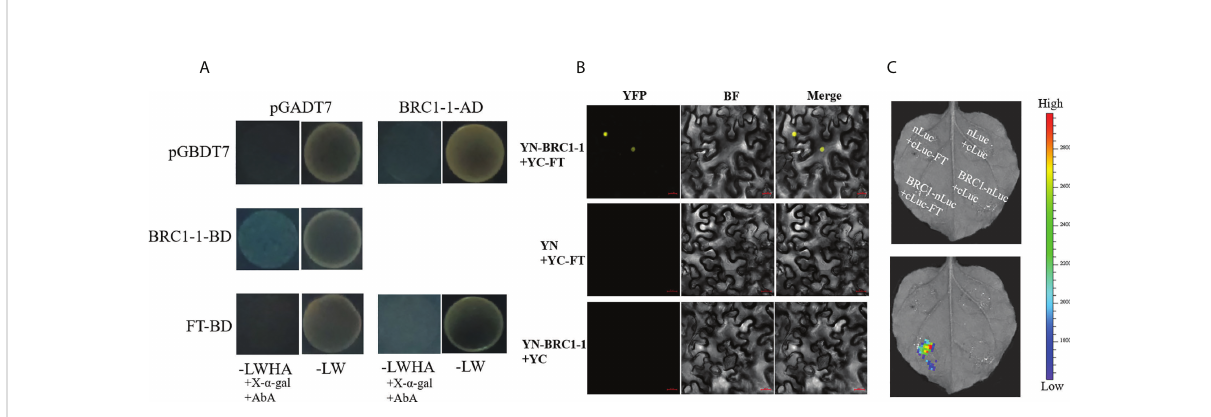
FIGURE 4 Interaction analysis between BjuBRC1-1 and BjuFT. (A) Yeast two-hybrid assay between BjuBRC1-1 and BjuFT. (B) BiFC assays between YN- BjuBRC1-1 and YC-BjuFT. YFP, YFP fl uorescence; BF, bright- fi eld; Merged, merged image of YFP and BF (C) LCI assays of BjuBRC1-nLuc with